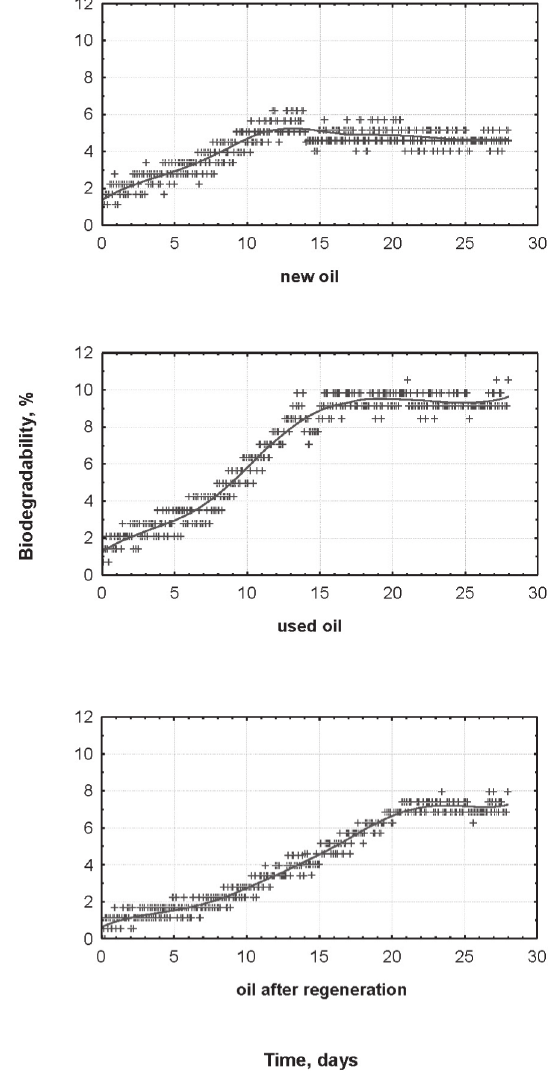
Fig. 5 – Regression analysis of growth inhibition of Sinapis alba root